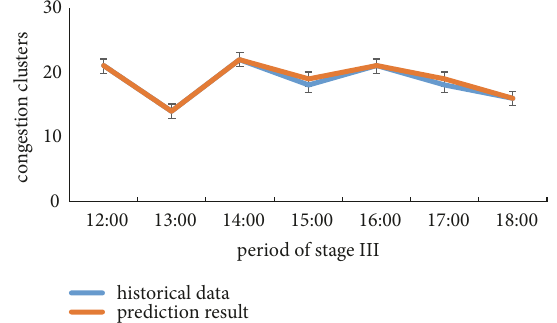
Figure 12: Comparison between the prediction result and historic data for stage III.